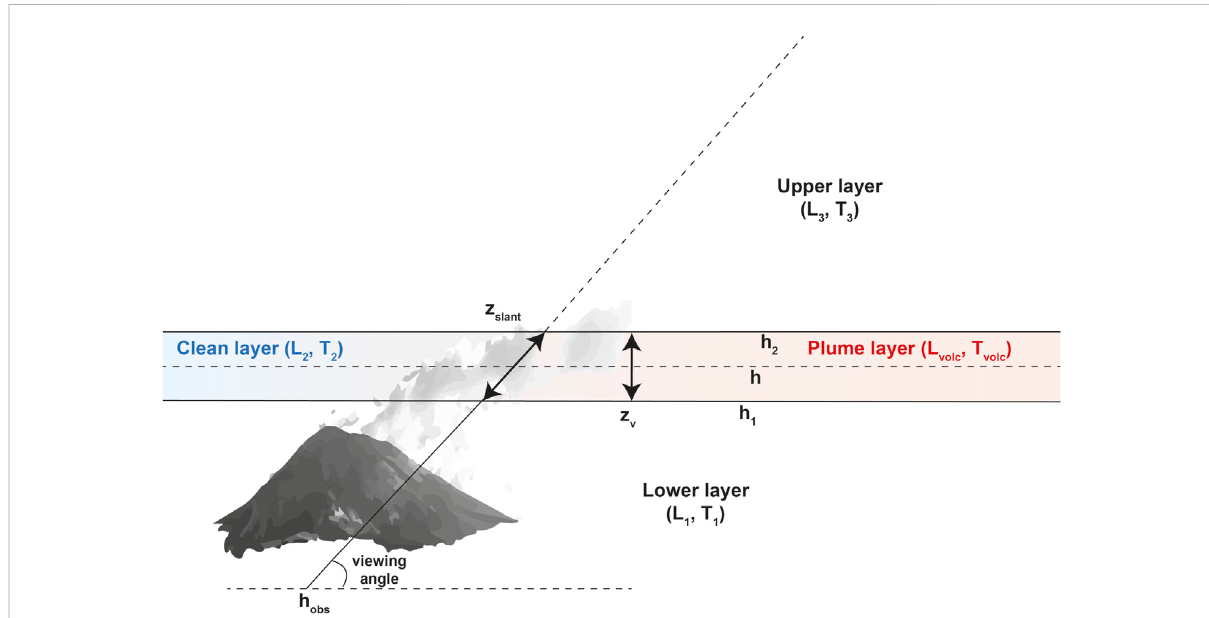
FIGURE 3 Simpli fi ed model of the viewing geometry and key parameters de fi ning the measurements. h obs : observer altitude; viewing angle : zenith angle determining the slant line-of-sight through the atmosphere; h : plume centre height; h 1 : plume bottom height; h 2 : plume top height; z v : plume verticalthickness; z slant :plumethicknessalongtheline-of-sight; L i :layerradiance; T i :layertransmittance.Inthemodel,theplumelayercontainsonly the volcanic species, and coexists with the slice of “ clean ” air in layer